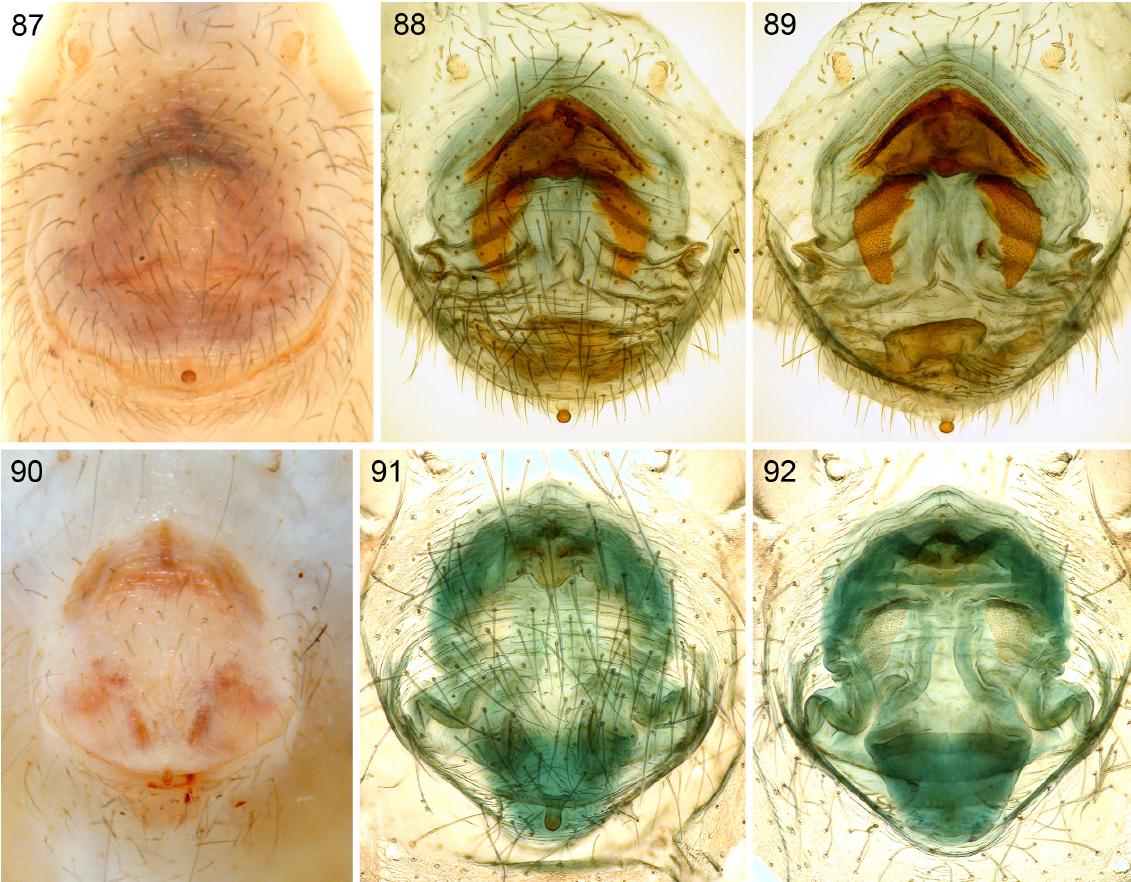
89 . Pholcus bukittimah Huber sp. nov. (ZFMK, Ar 15707). 90–92 . P. barisan Huber sp. nov. (ZFMK, Ar